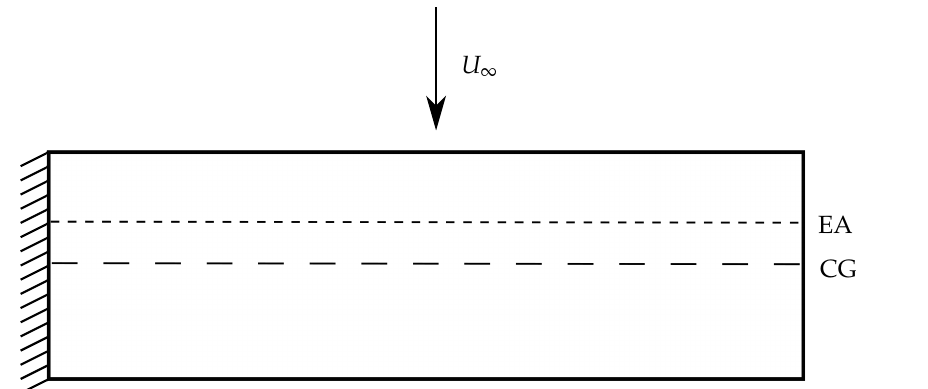
Figure 7. Goland’s wing model layout. Table 1. Goland’s wing properties and flight condition [57].